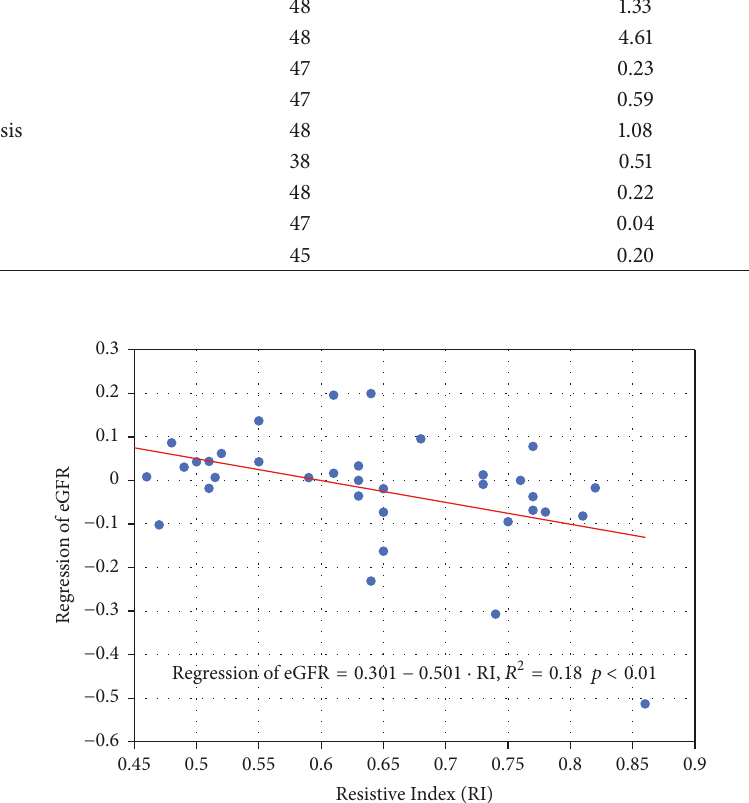
Figure 3: RI and regression of eGFR. Baseline RI was significantly correlated with deterioration of renal function. RI: resistive index. eGFR: estimated glomerular filtration rate. Regression of eGFR was calculated as log(eGFR y1) − log(eGFR